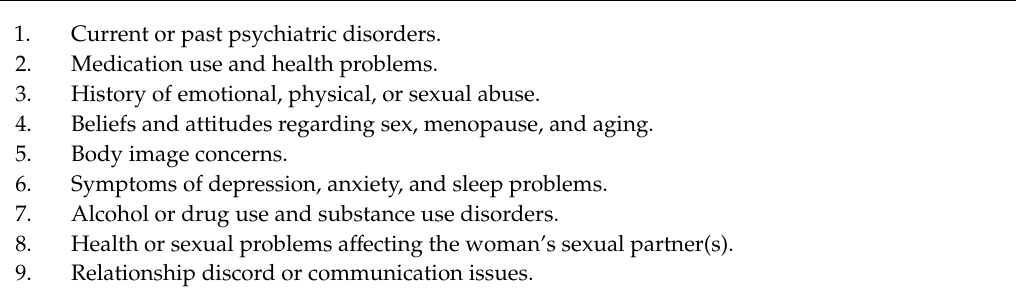
Table 3. Main data to be collected in the clinical history in case of symptoms of sexual dysfunction. Information that should be collected in the medical record by health providers in response to